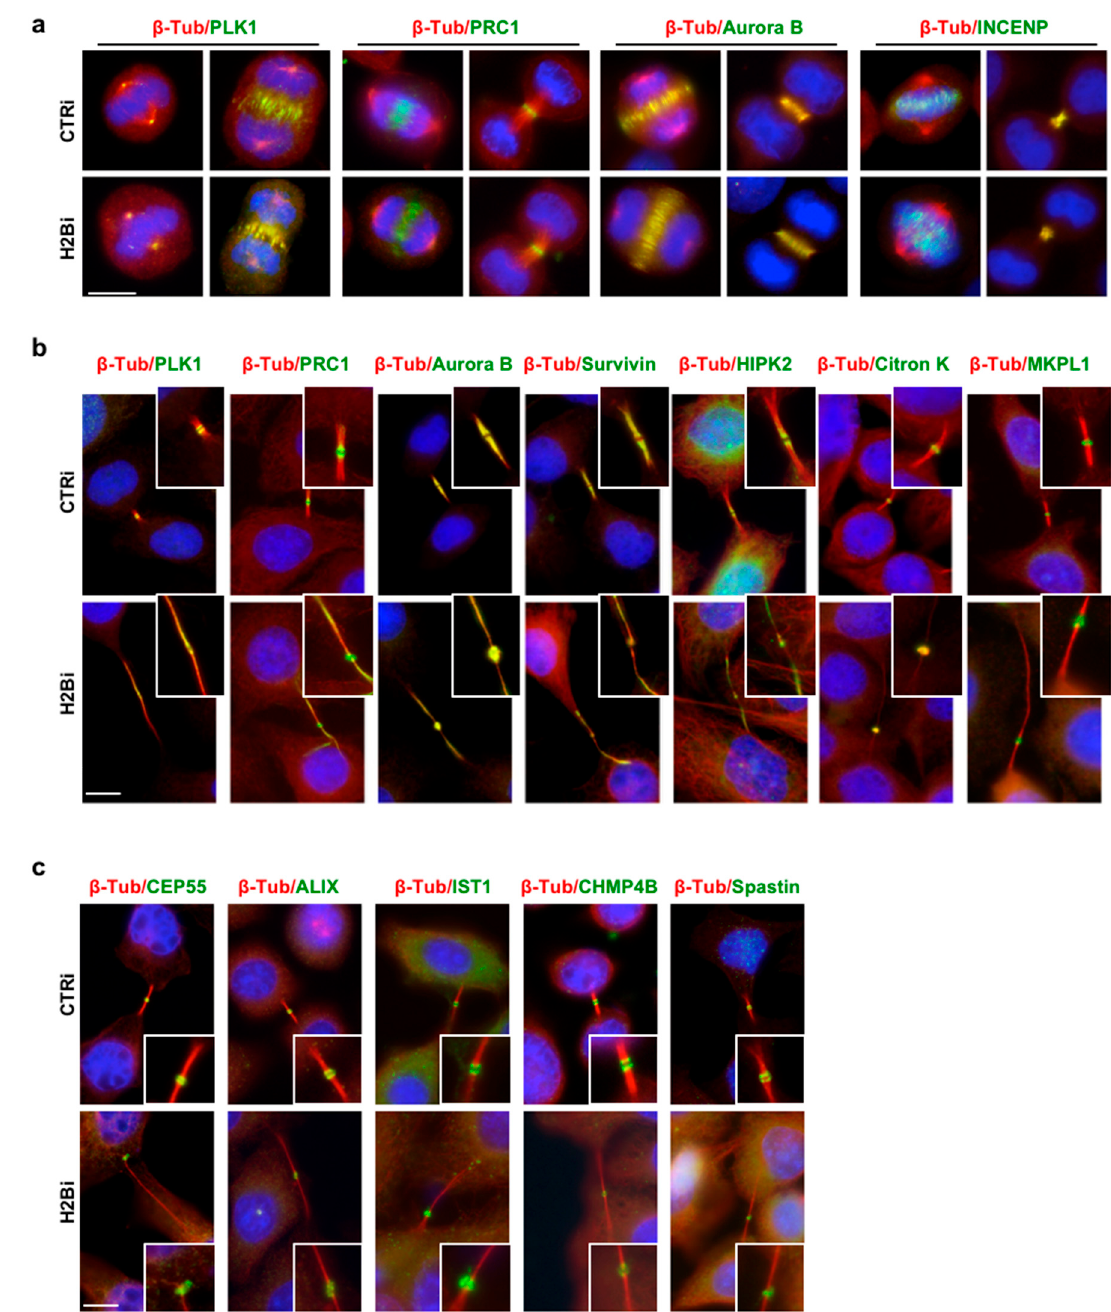
Figure 3. ecH2B depletion does not affect the recruitment of cytokinetic proteins. Proliferating, asynchronous HeLa cells were depleted for histone H2B, as described above, and analyzed by double IF for β -Tubulin (red) and the indicated proteins (green); DNA was marked with Hoechst (Blue). The analyzed proteins are associated with ( a ) central spindle formation and cleavage furrow ingression, ( b ) midbody formation, and ( c ) abscission machinery. Representative images of CTRi and H2Bi HeLa cells are shown. At least 20 metaphases and anaphases in ( a ) and 50 cytokinetic cells in ( b ) and ( c ) from two independent experiments have been scored. For each of the analyzed proteins, no significant difference was observed in the percentage of positive ICBs that was > 98% in both H2Bi and CTRi cells. Scale bar is 10 μ m.